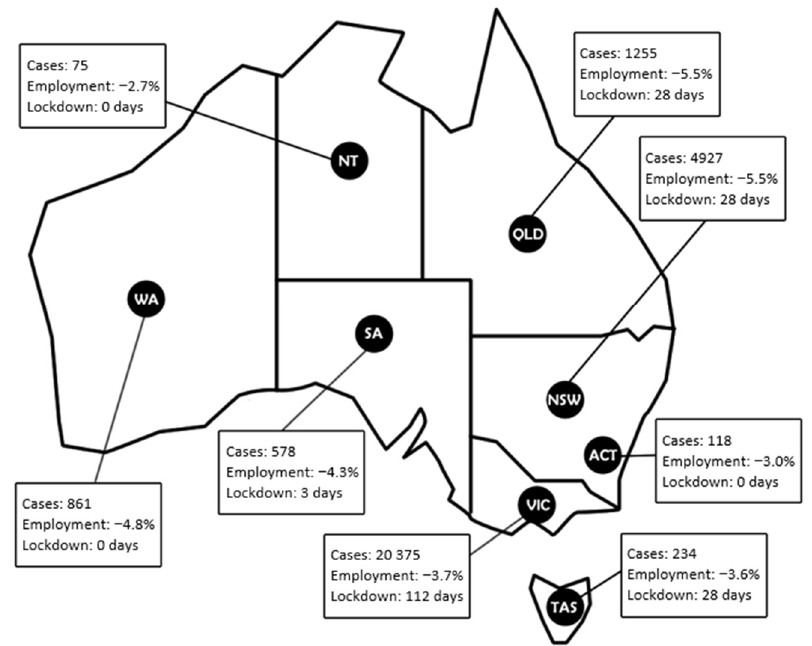
Figure 1. COVID ‐ 19 cases during 2020 and seasonally adjusted change in percentage